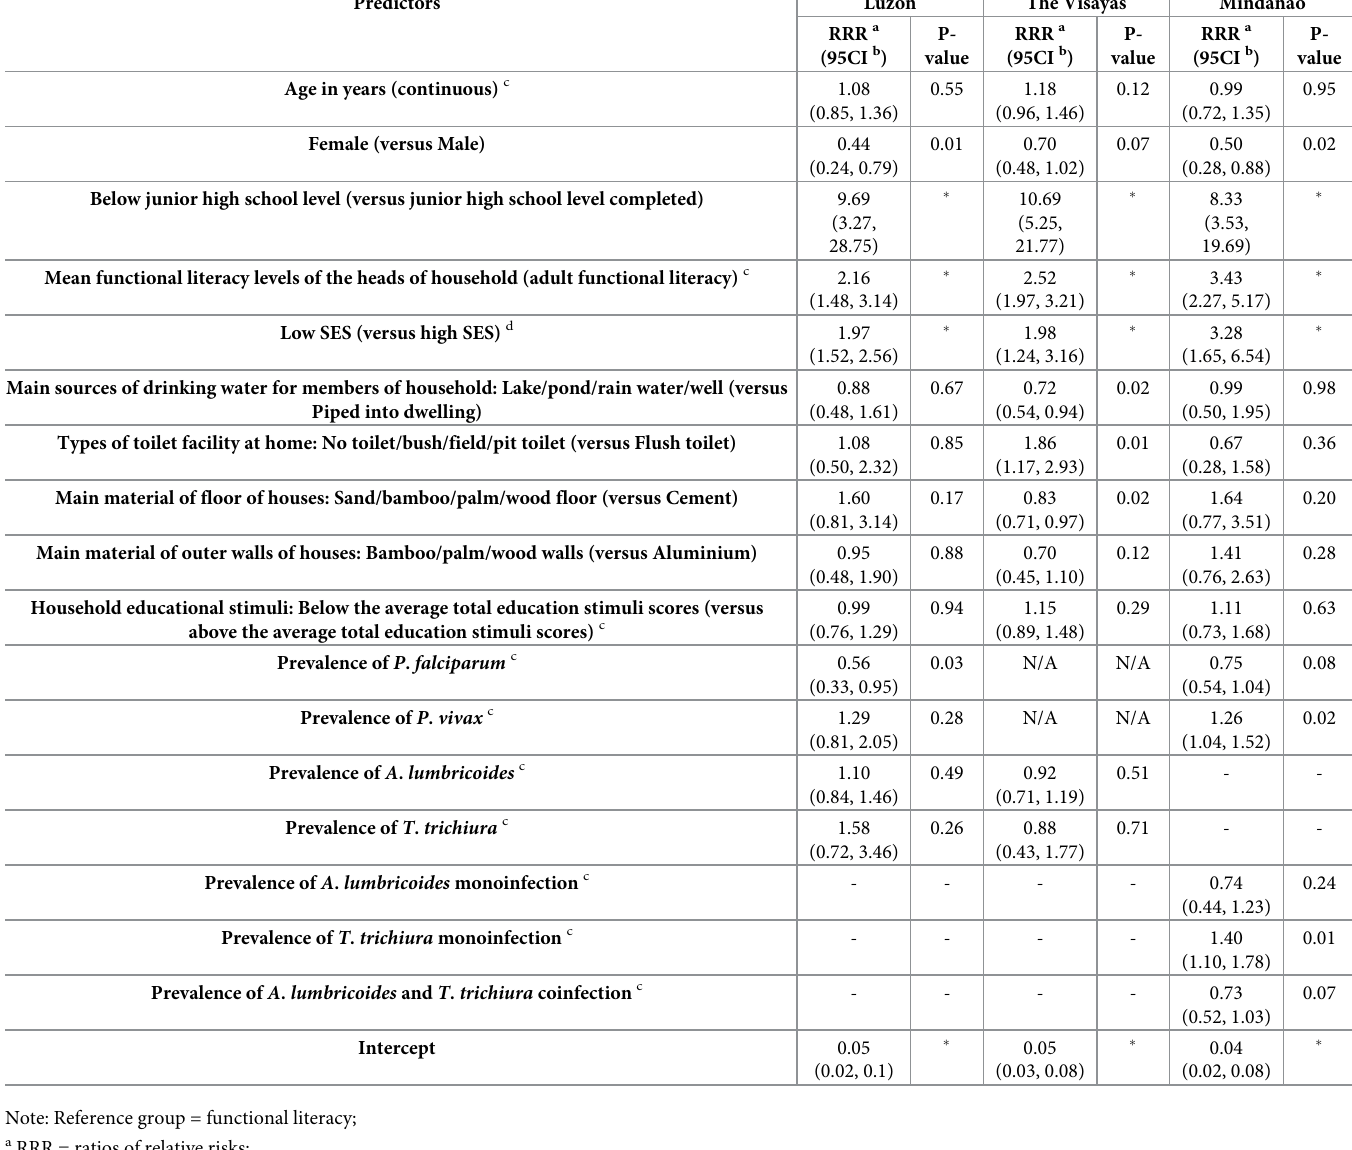
Table 6. List of predictors considered as influencing the prevalence of functional illiteracy in school-aged children.